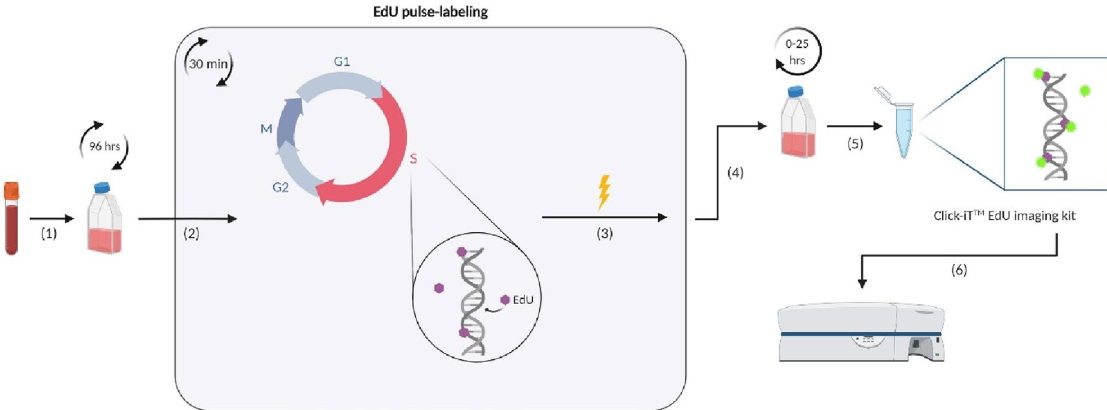
Figure 1. Schematic overview of the EdU pulse-chasing method for tracking T lymphocytes cultured in whole blood. ( 1 ) Whole blood is cultured and lymphocyte cell division is stimulated using PHA. ( 2 ) After 96 h of culture, the proliferating cells are pulse-labeled with 10 µM EdU for 30 min; and ( 3 ) during pulse-labeling, the cells are irradiated in vitro with 2 or 4 Gy of X-rays. ( 4 ) EdU pulse-chasing is performed by culturing the cells from 0 up to 25 h and chasing them over time. ( 5 ) Following red blood cell lysis, the lymphocytes are fixed and then stained using the Click-iT EdU imaging kit. ( 6 ) The samples are measured using flow cytometry and analyzed using FlowJo